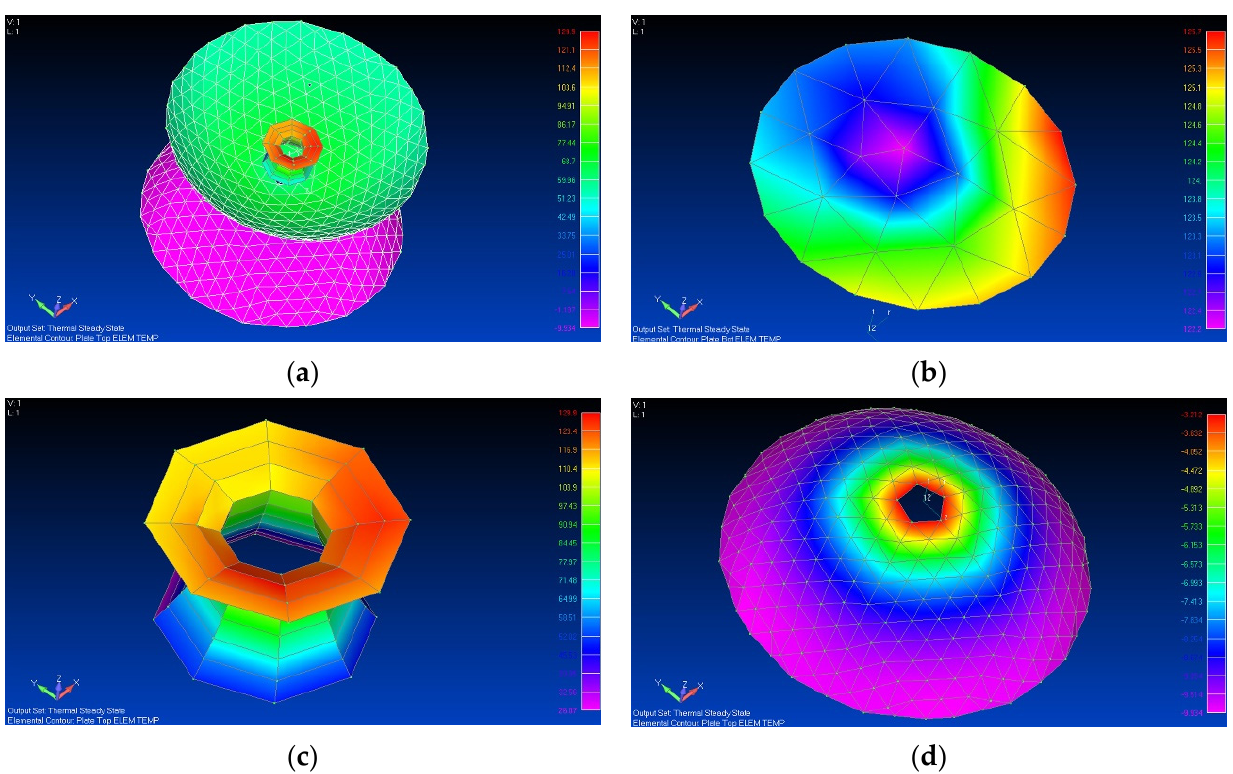
Figure 17. Temperature distribution of two-layer ring truss-based SSPS in orbit: ( a ) the whole system;